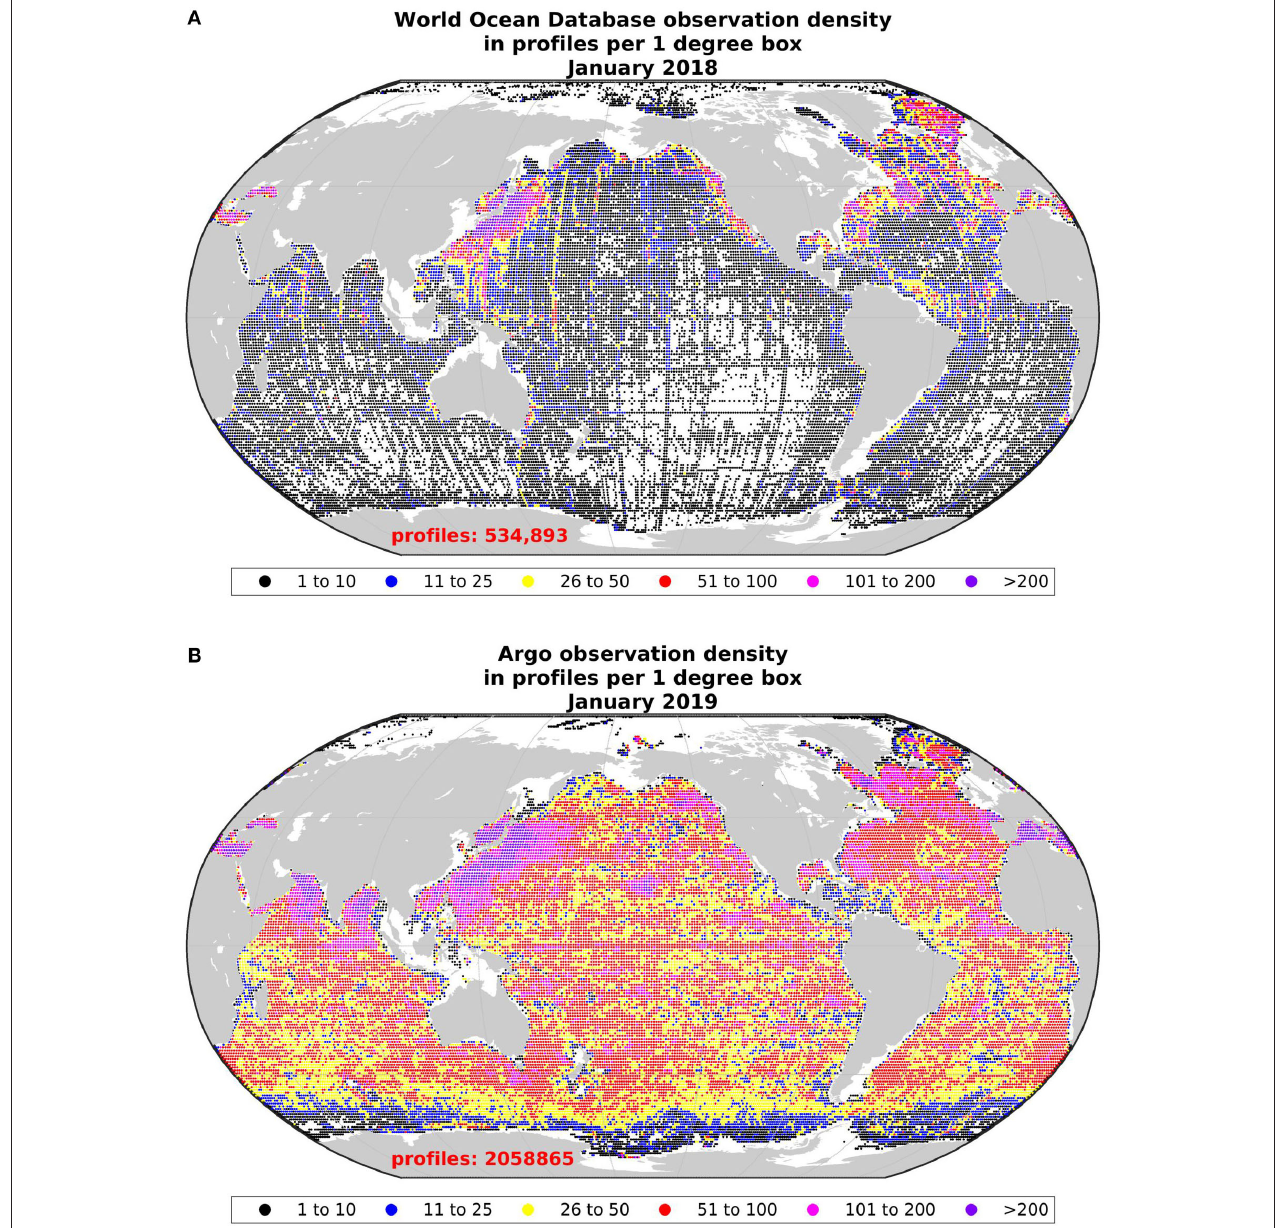
FIGURE 14 | Total number of profiles with temperature and salinity that extend to at least 1,000 dbar for every 1 ◦ square of latitude and longitude. (A) World Ocean Database 2013 with updates from January 2018. These represent profiles collected by research or other vessels over the past 150 years. (B) Profiles collected by Argo up to January